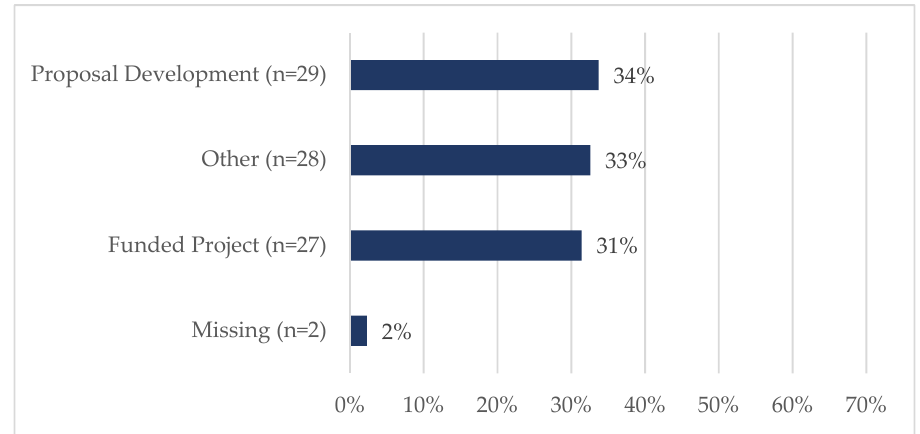
Figure 4. The project details associated with each request through the TAG-SC during Phase II: Pilot Year and Phase III: Year 1 of TAG-SC (N = 86).